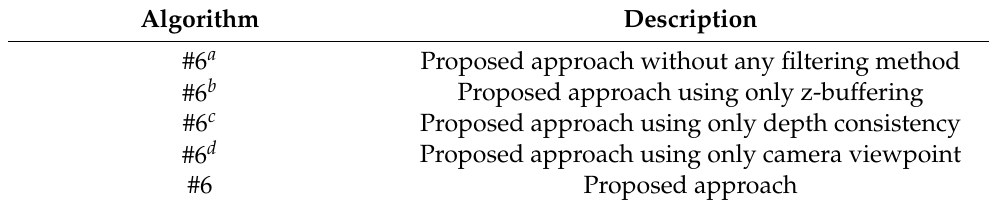
Table 3. Variants of the proposed approach used to evaluate the impact of the filtering